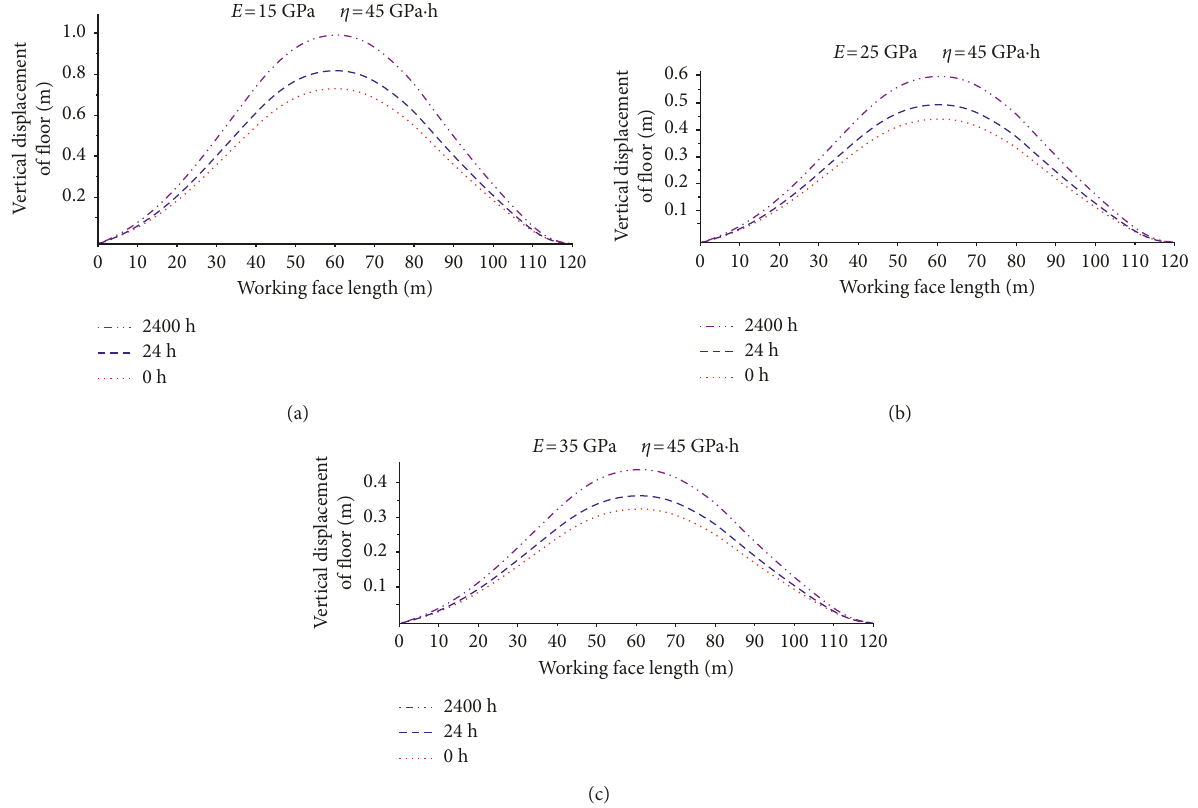
Figure 11: Deformation deflection curve with different elastic moduli. (a) E